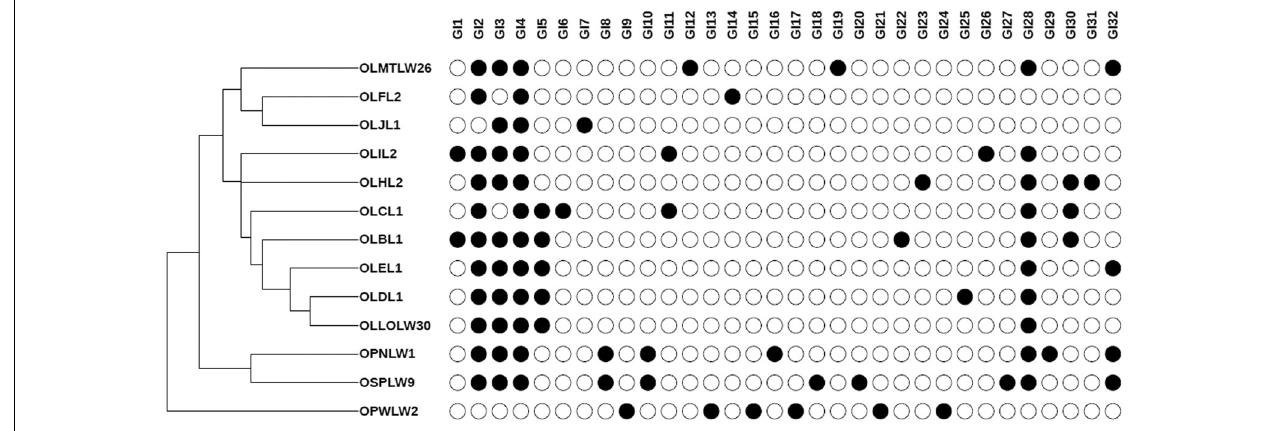
FIGURE 4 | Genomic Islands profiles in Orius derived, Serratia- like facultative symbionts. Presence–absence map showing the distribution of representative GIs per genome (C). GI number corresponds to those described in Supplementary Table 7. Dendogram generated based on GI presence/absence per